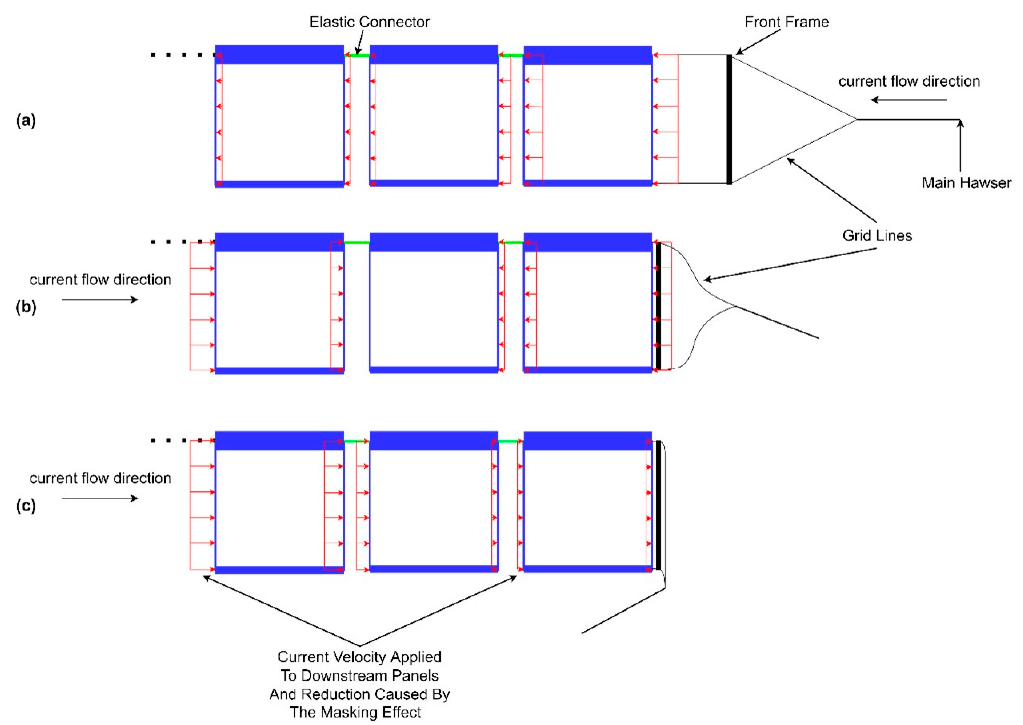
Figure 3. A simplified vertical side schematic view of the SPM system, showing current load symbols according to current flow direction and the state of the system: ( a ) the initial state, where the system is tensed by the prevailing current; ( b ) the Drift State, where sudden opposing current starts drifting the system toward the anchor (here the load symbols shows the sum of the current loads and reacting inertia loads); ( c ) the holding by the anchor state, after the system drifted with no yaw rotation, until being held by the anchor line at the most unfavorable situation to buckling.